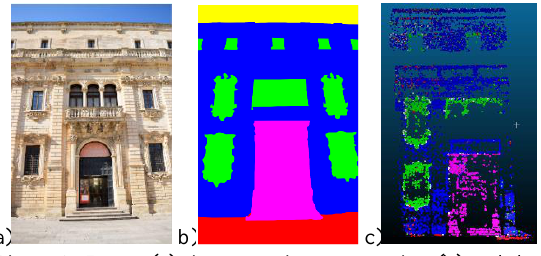
Figure 9: Image (a), its semantic segmentation (b) and the labelled sparse point cloud after label transfer